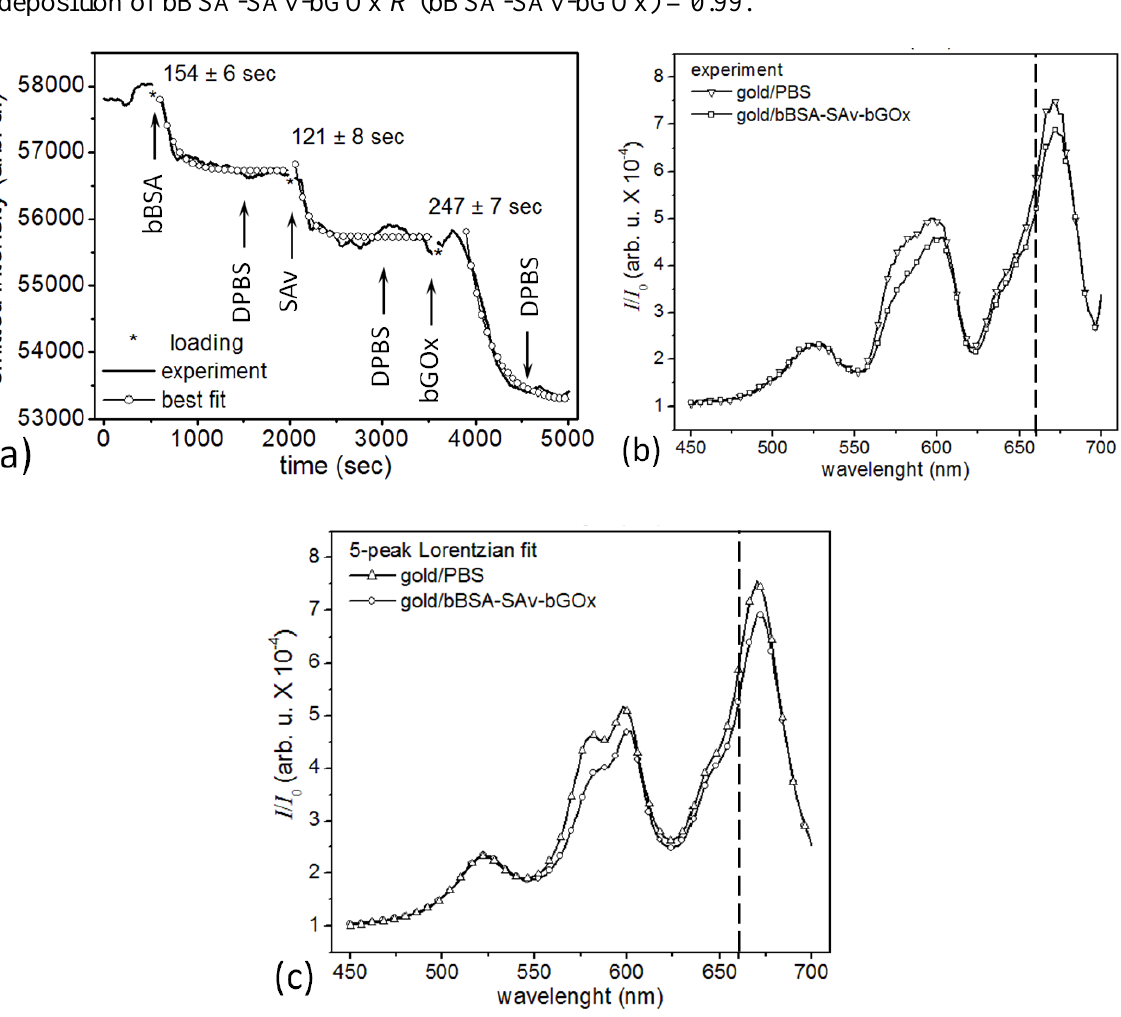
Figure 6. ( a ) Monitoring the successive binding of three molecular layers to a microsensor: a microsensor’s emitted-light intensity at 660 nm (dashed line in Figure 6(b) and 6(c)) during: (i) covalent binding of 10-µM bBSA solution to the microsensor’s bare-gold